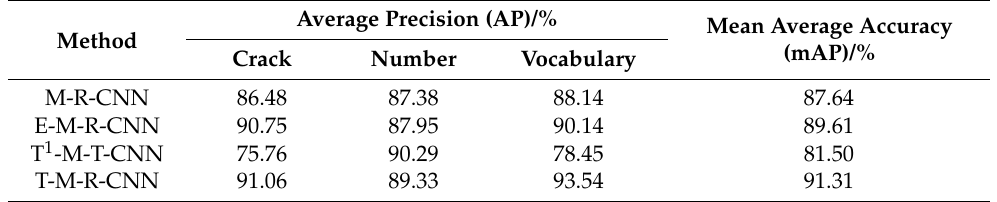
Figure 10. Training loss of T-M-RCNN model. Table 1. Comparison of detection Table 1. Comparison of detection accuracy.